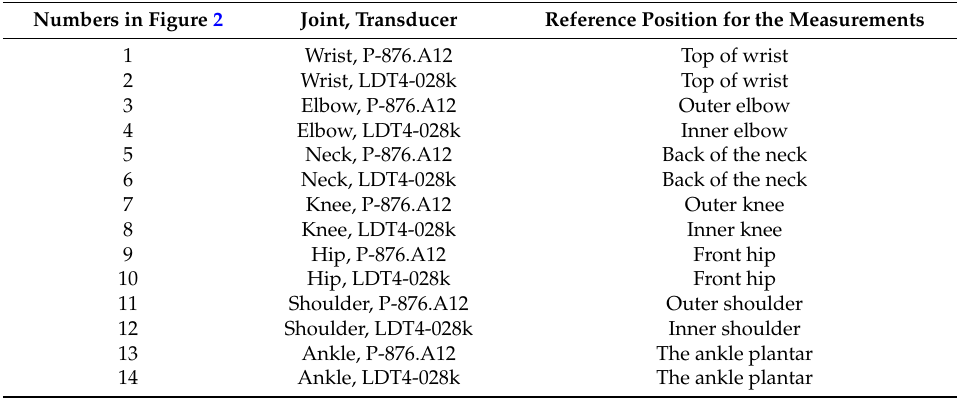
Table 4. Positions of the transducers on the suit and on the belt.